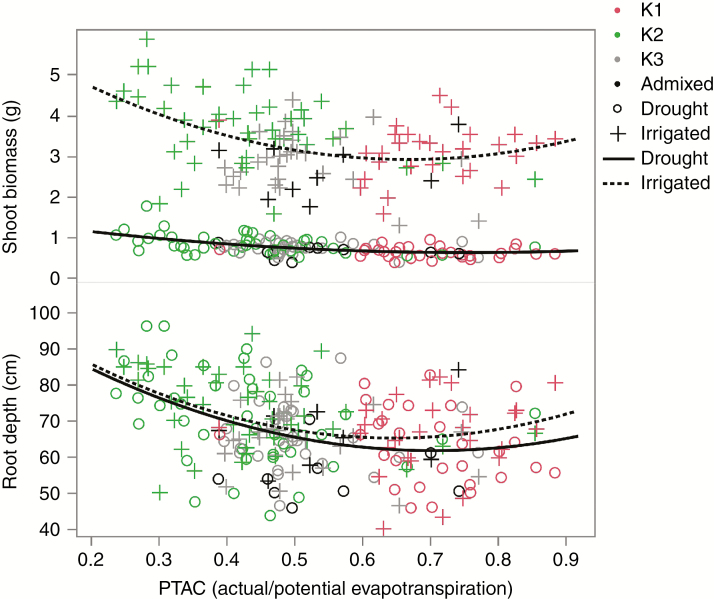
Linear and quadratic regression analyses of shoot biomass and root depth as explained by aridity (PTAC) in irrigated (dotted lines) and drought (solid lines) treatment. The colours of the points represent the population groups identified by structure analysis.